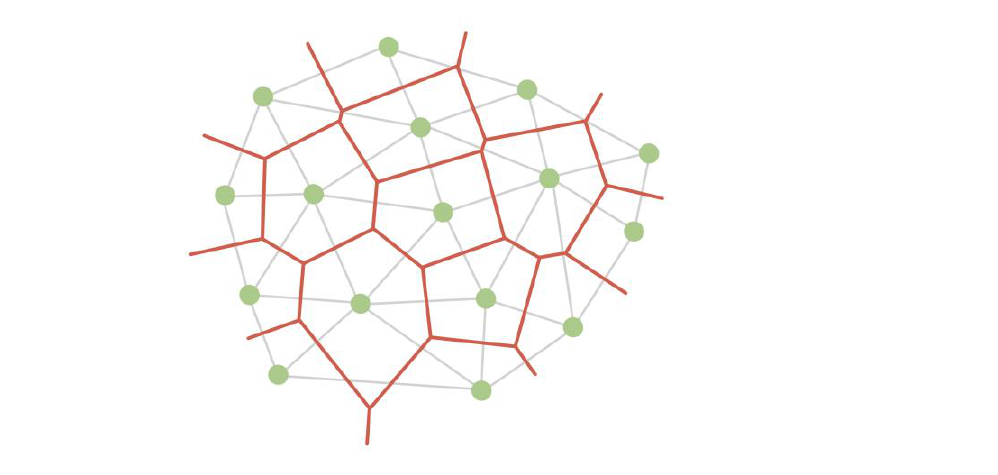
Figure 16. A Voronoi diagram (red) partitions a plane into cells based on triangulation (grey edges) of centroids (green vertices).